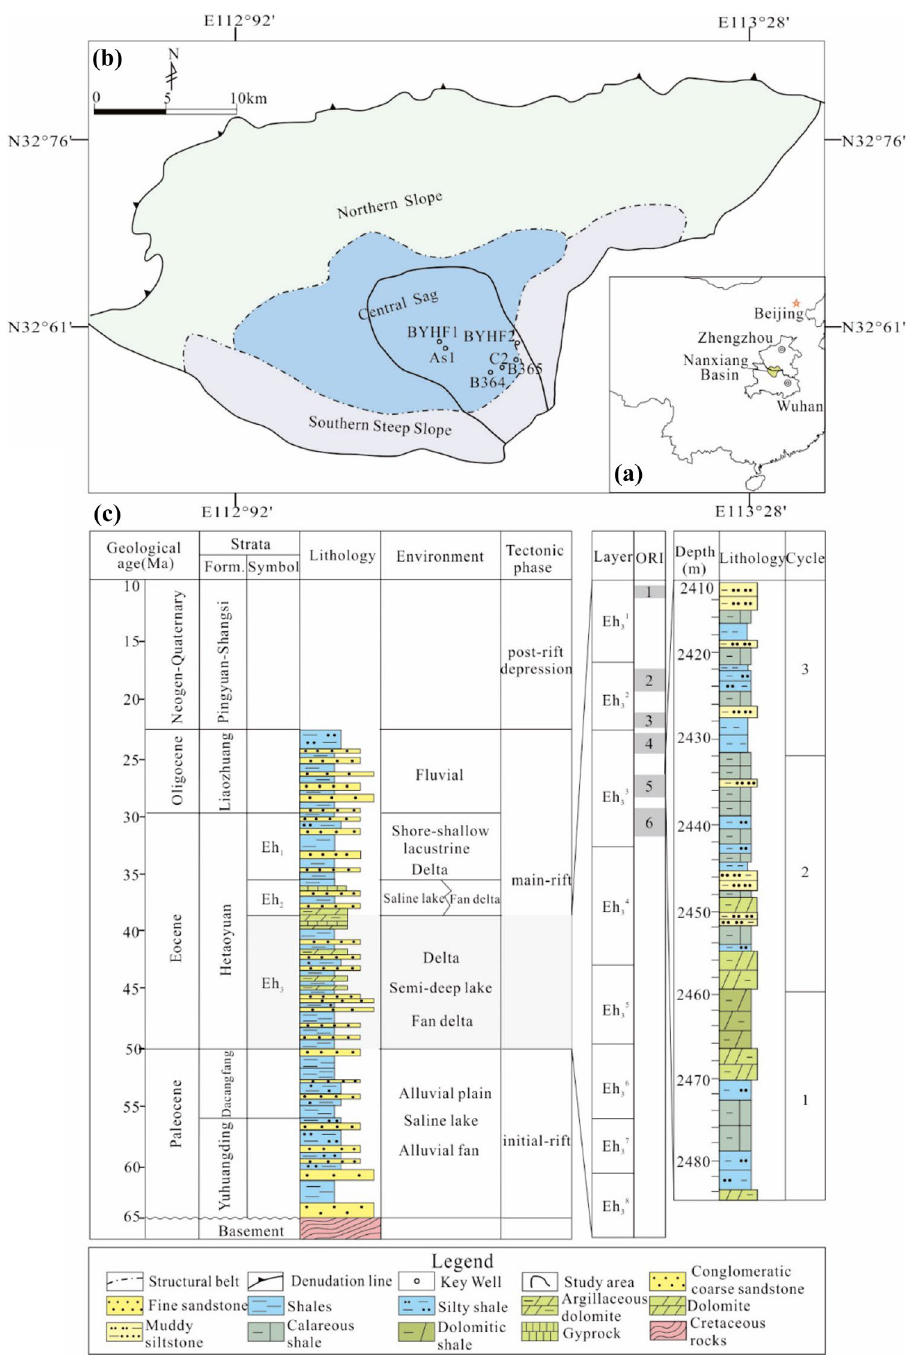
Fig. 1 a Sketch map of China showing location of the Nanxi- ang Basin; b structural units of the Biyang Depression and location of the study area and key wells; c generalized strati- graphic columns of the Biyang Depression and the lithologic sequence of ORI